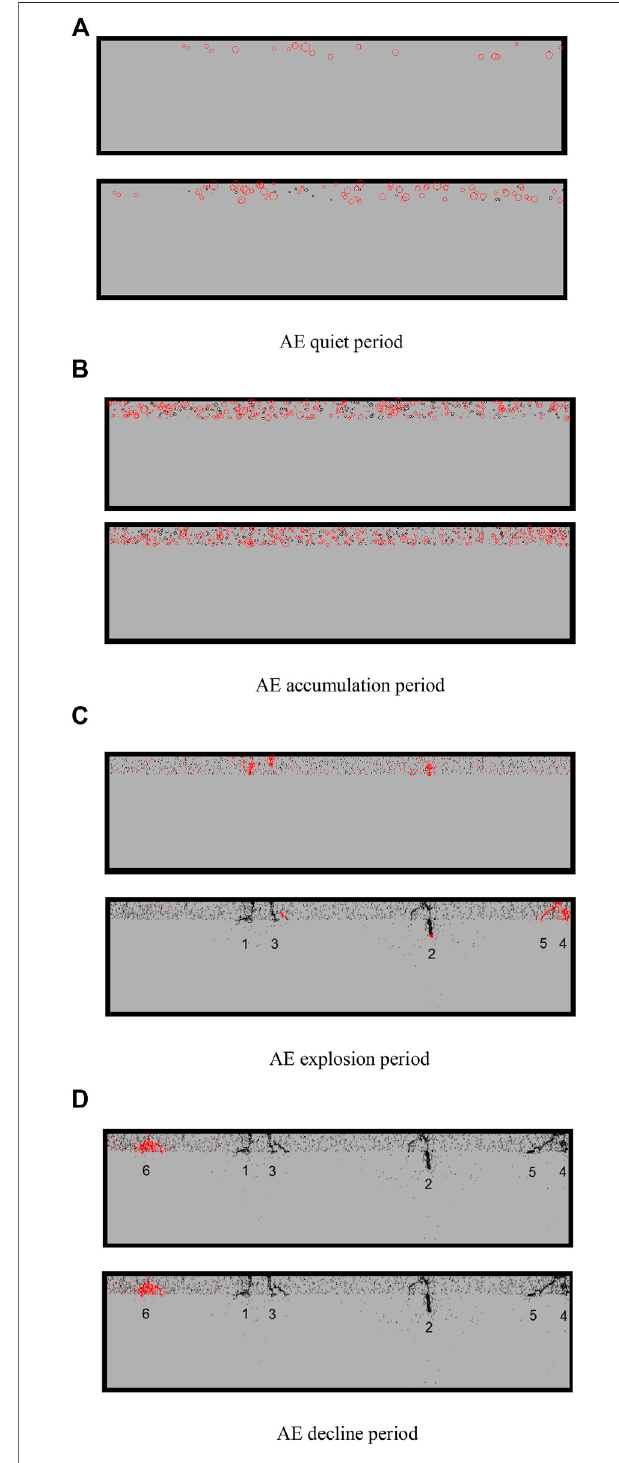
FIGURE 6 | AE evolution with cooling down 2 ° C per step. (A) AE quiet period, (B) AE accumulation period, (C) AE explosion period, and (D) AE decline period.